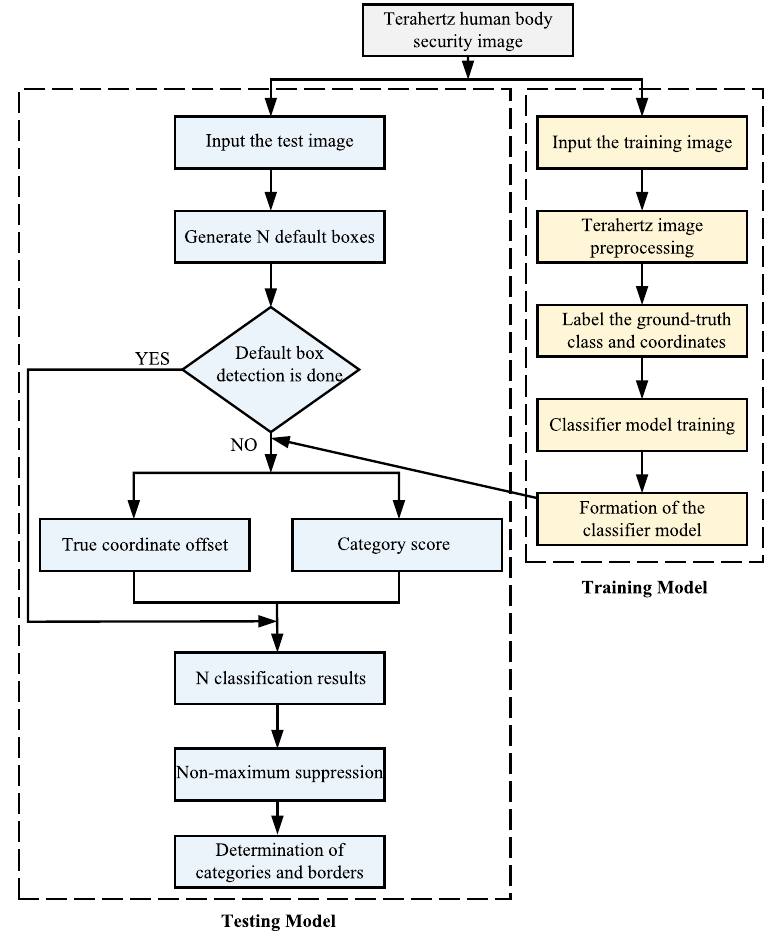
Figure 3. Flowchart of the algorithm.